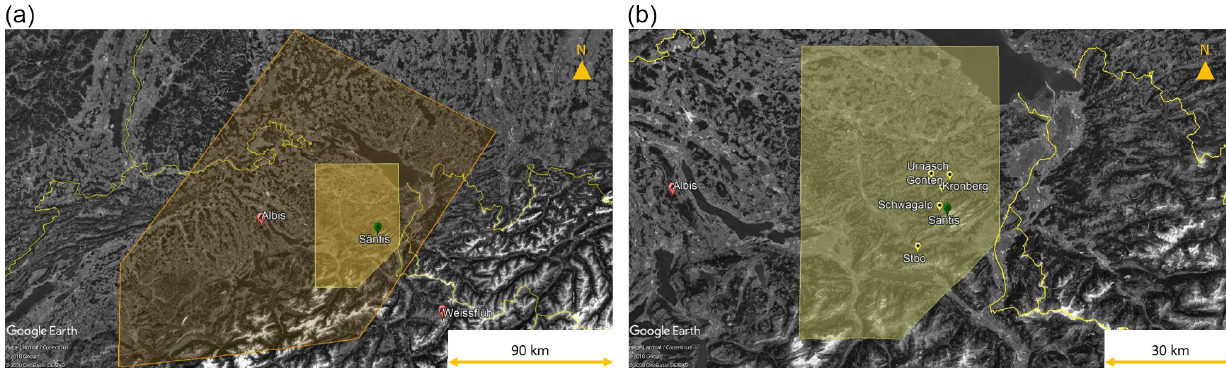
Figure 1. (a) Approximate extent of the maximum area covered by the LMA (orange polygon). The yellow area shows the region with more comprehensive coverage. (b) Zoom over the best covered area with the locations of the LMA stations. Radar positions are marked by red dots while the position of the LMA sensors is marked by yellow dots. The Säntis tower is marked by a green